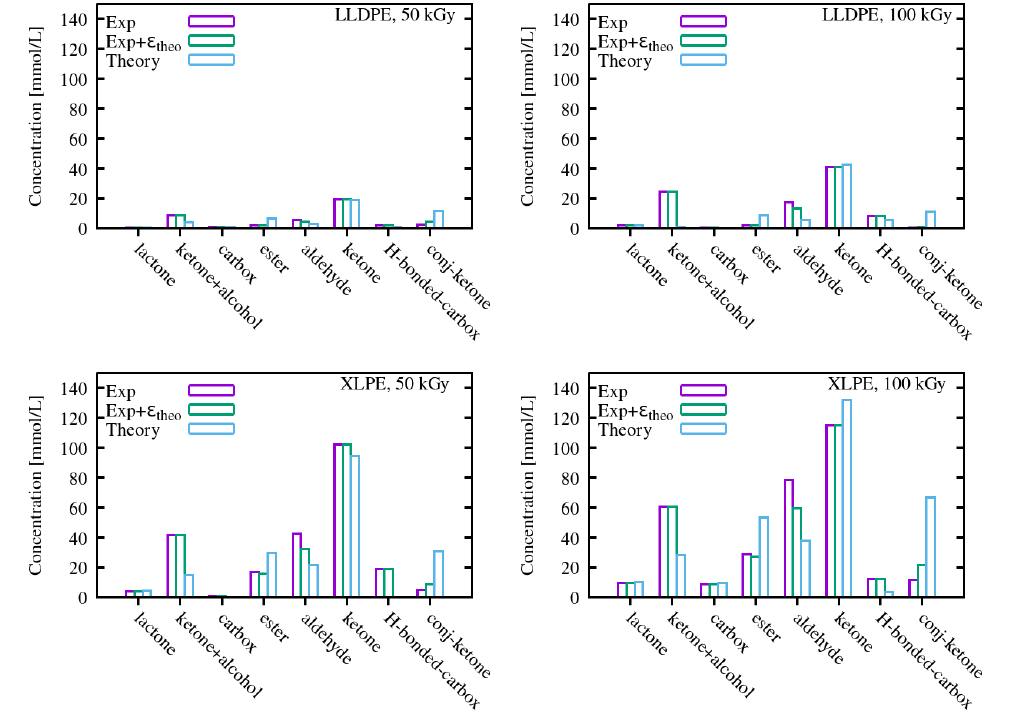
Figure 7. Concentrations of various species as determined from FTIR spectra deconvolution for LLDPE and XLPE for two irradiation doses. We show concentrations obtained with three different sets of fitting parameters, coming only from experiments (“Exp”), only from theory (“Theory”), or from a combination of them (“Exp + ε theo